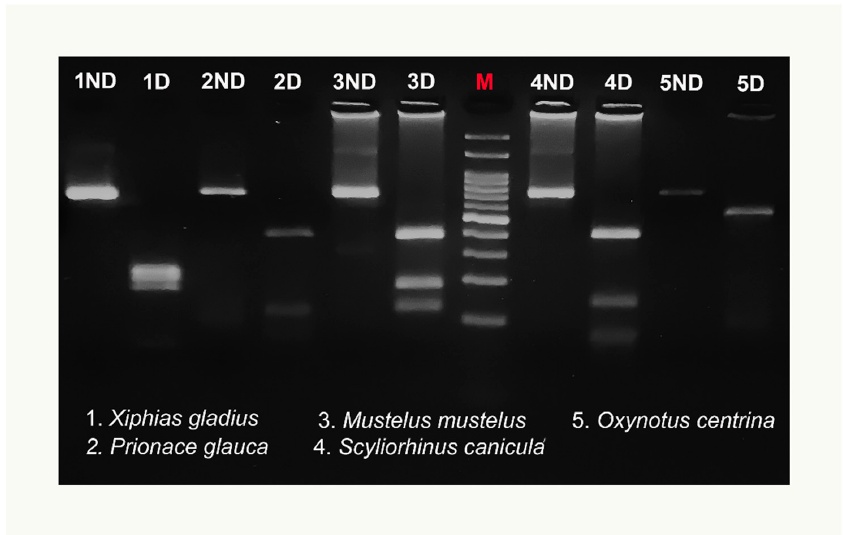
Figure 3. Example of COIBar–RFLP identification of swordfish and shark species on a 3% agarose